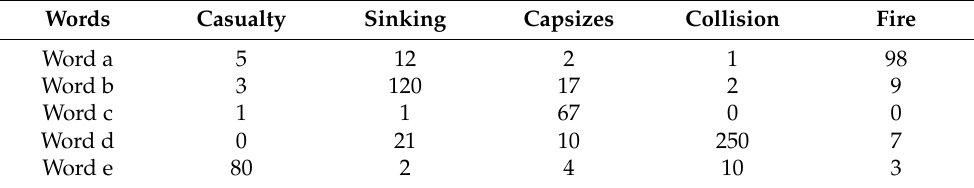
Table 2. Example of word appearance